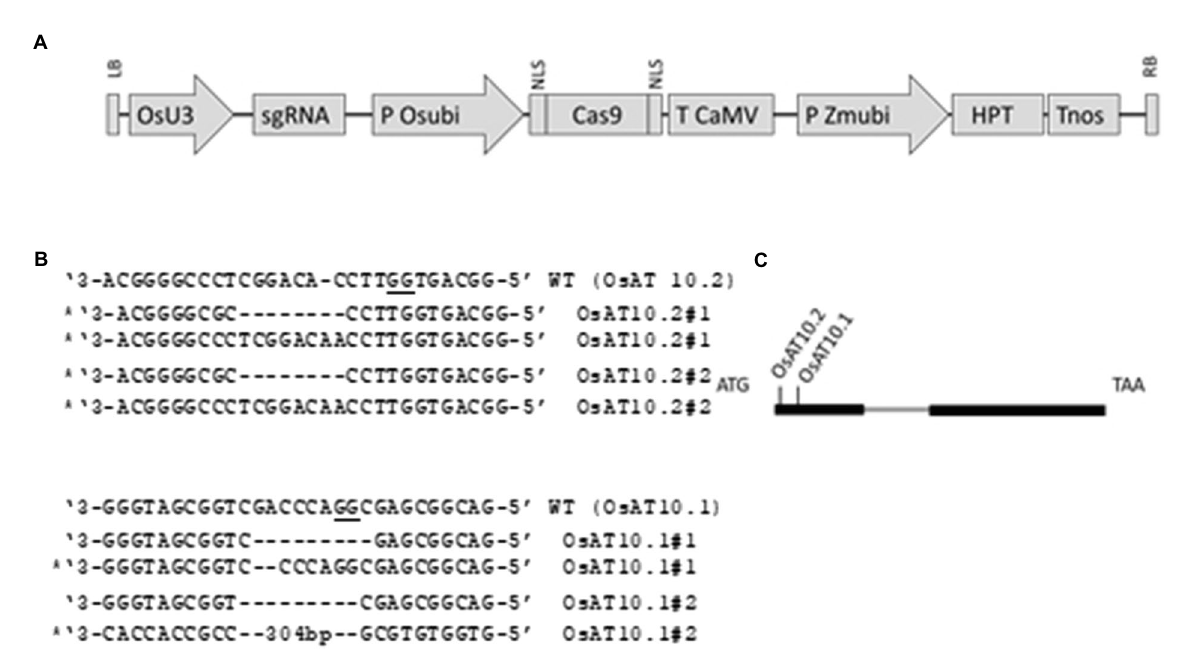
FIGURE 1 Constructs used and targets for CRISPR/Cas within OsAT10. (A) Schematic presentation of the T-DNA structure in the vectors utilized in this study. The expression of the sgRNA scaffold is driven by the rice U3 promoter (OsU3), expression of Cas9 by the rice ubiquitin promoter (P Osubi) and expression of hygromycin selection marker (HPT) by Maize ubiquitin promoter. Abbreviations: NLS, nuclear localization signal; Tnos, Nopaline terminator; T CaMV, Cauliflower Mosaic Virus (CaMV) 35S terminator; LB, Left border; RB, right border. (B) Indels present in the original lines, KO lines selected are marked and PAM is underlined. (C) Schematic of the OsAT10 gene structure and target site. The intron is marked with gray and the two exons are shown with thick black lines. The location of the two crisprs are